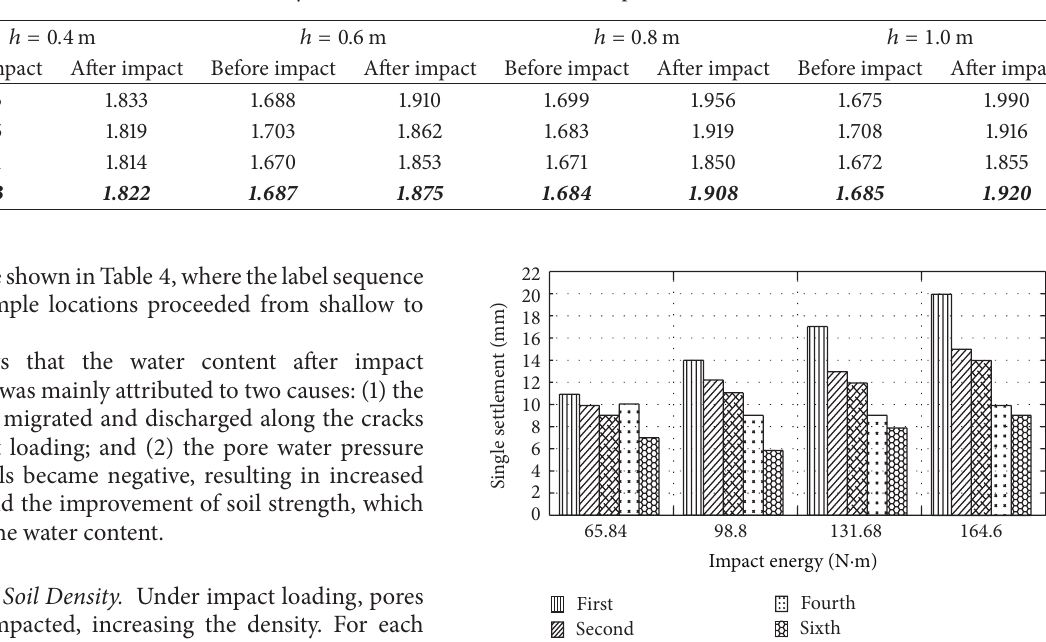
Table 5: Density of soils below the bottom of the impacted holes.